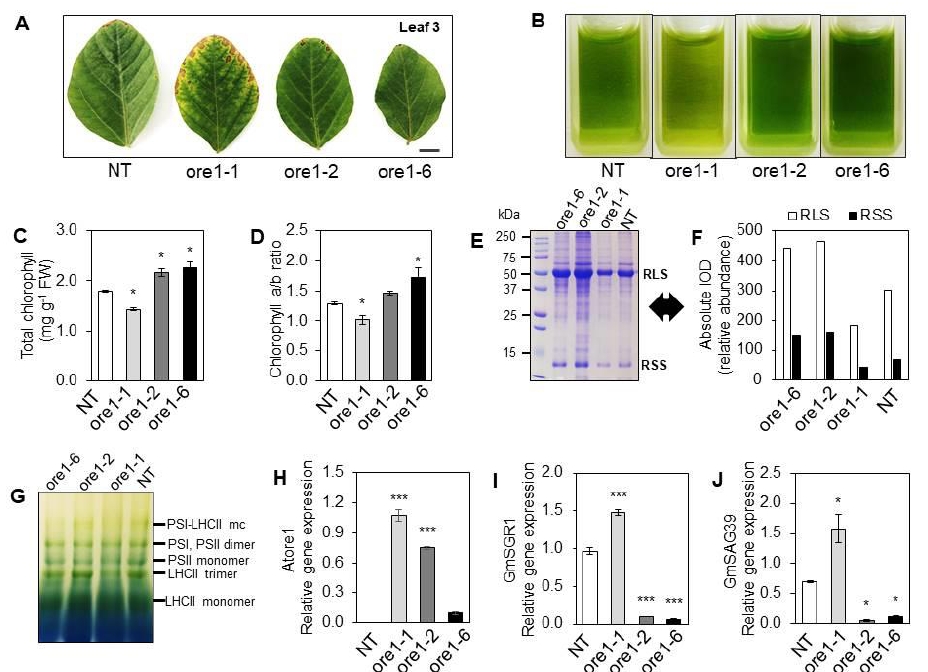
Figure 2. Phenotypic characterization of At-ore1 expression in soybean leaves (leaf 3) at V3-vegetative stage. ( A ) Fully expanded leaf 3 phenotype of NT, ore1 -1, or1-2 and ore1 -6, respectively, bar 1 cm. ( B ) Chlorophyll extraction of the detected leaves of the NT and ore1 -1, ore1 -2, ore1 -6. ( C ) Total chlorophyll content in the leaf 3 of NT, ore1 -1, or1-2 and ore1 -6. ( D ) Ratios of chlorophyll a and chlorophyll b (Chla:Chlb) of NT, ore1 -1, ore1 -2 and ore1 -6. ( E , F ) Total protein profile in the detached leaves of NT, ore1 -1, ore1 -2 and ore1 -6, including rubisco large subunit (RSL) and rubisco small subunit (RSS). Each lane was loaded with 50 µ g protein. Molecular mass markers (kDa) are listed on the left of the gel. ( F ) The bands of RLS and RSS were quantified and expressed as absolute integrated optical density (IOD). ( G ) Chl-binding protein in thylakoid membranes were measured by photosystem I/II (PSI/PSII) and light-harvesting complexes (LHC). Relative gene expression of At-ore1 ( H ), STAYGREEN 1 ( GmSRG1 ) ( I ), and soybean-senescence-associated gene 39 ( GmSAG39 ) ( J ) were analyzed by qRT–PCR using leaves (No.3) of NT and ore1 -1, ore1 -2, ore1 -6 plants. Data are means ± SE of three independent biological replicates ( n = 3). Asterisks indicate significant differences from NT and transgenic plants according to Tukey’s t -test; * p < 0.05, *** p < 0.001. A more detailed analysis of the Chl content revealed that the lower Chla:Chlb ratio in the ore1 -1 line was almost entirely due to the total protein profile. The result of SDS-PAGE staining revealed a significant decrease of 39.3% and 37% of the rubisco large subunit (RLS) and rubisco small subunit (RLS) in ore1 -1 compared with NT, respectively (Figure 2E,F). Likewise, we further analyzed the relative amount of Chl-binding protein of photosynthetic components by BN-PAGE gel staining on isolated thylakoid membranes. The analysis of free pigments confirmed a relative decrease in the monomeric photosystem II (PSII) and trimeric light-harvesting complex (LHCII) in the ore1 -1 line compared to the wild-type. Among these components was a relative increase in the ore1 -2 and ore1 -6 lines (Figure 2G), while dimeric PSI, PSII, and monomeric LHCII were present at similar levels. The loss of Chl content in the ore1 -1 line is associated with the Chl degradation of LHCs. Further analysis of photosynthetic parameters in soybeans such as the STAY-GREEN 1 ( GmSGR1 ) and GmSAG39 genes indicated that these genes showed higher expression levels in the ore1 -1 line than in the NT; however, they were lower than in the ore1 -2 and ore1 -6